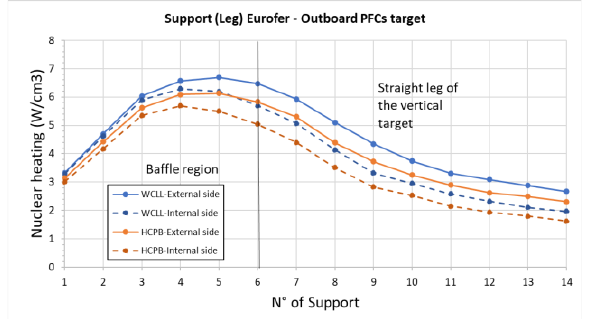
Figure 45. Outer poloidal profiles of the nuclear heating (W/cm 3 ) on PFC-CB supports made of Eurofer, comparing the values on the external and innermost target sides, both for WCLL and HCPB blanket case.